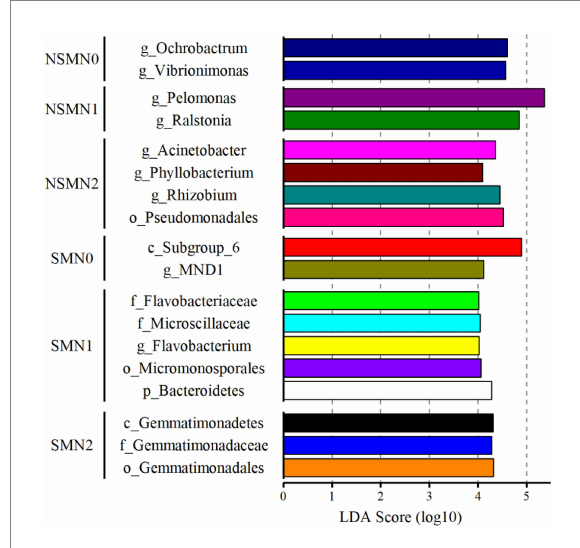
FIGURE 5 Differentially abundant taxa in wheat rhizosphere soil under straw mulching and N fertilization treatments. Detected using linear discriminant analysis effect size analysis. NSM, no straw mulching; SM, straw mulching; N0, no N; N1, 120 kg N ha − 1 ; N2, 180 kg N ha − 1 .